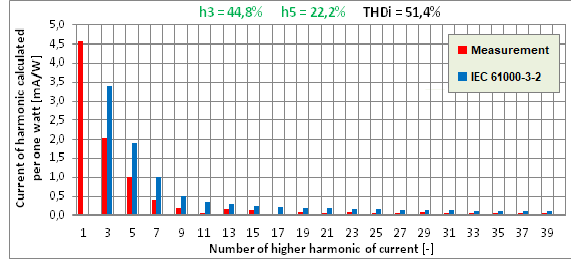
Fig. 3. Harmonic spectrum of current in 8 W LED lamp